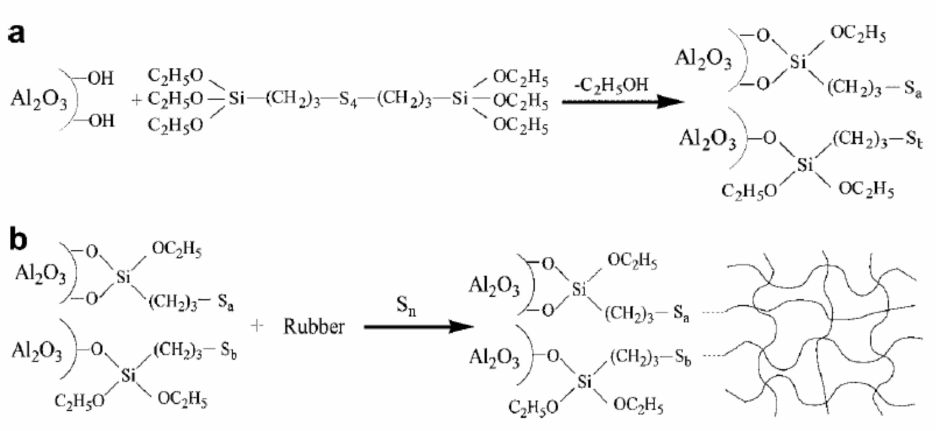
Figure 9. ( a ) In situ surface silanization of α -Al 2 O 3 nanoparticles; ( b ) expected reaction between functionalized α -Al 2 O 3 and rubber chains during the vulcanization process [97]. Copyright © 2021 John Wiley & Sons, Ltd.